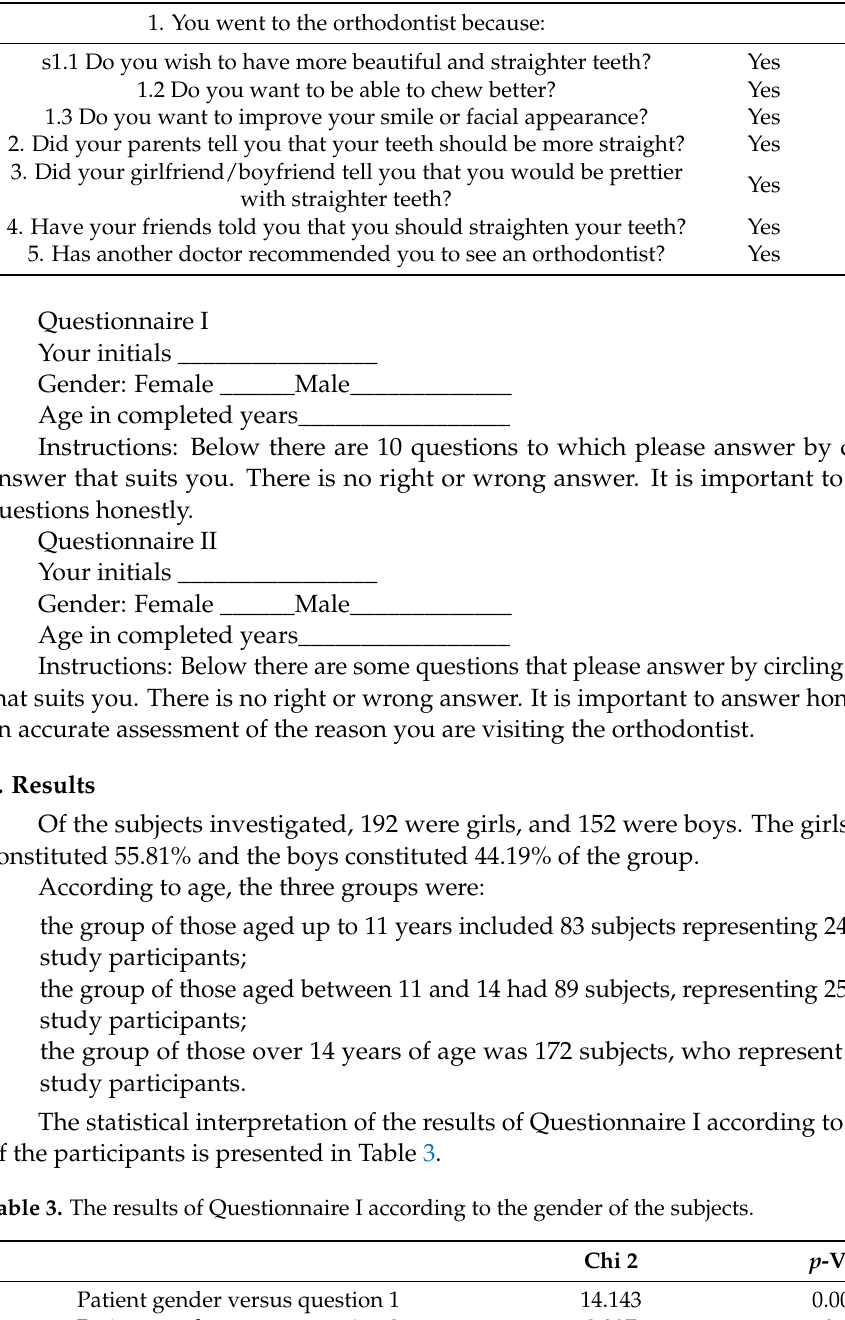
Table 2. Questionnaire II.